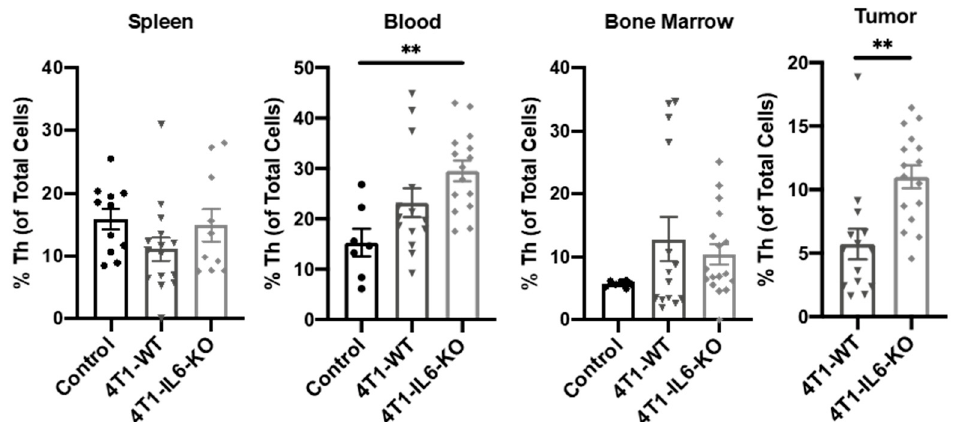
Figure 10. Knocking out tumor cell IL-6 production increases tumor-infiltrating CD3 + /CD4 + T helper cells. Tumors and peripheral tissues harvested 28 d after engraftment of 4T1-WT and 4T1-IL6-KO cell lines were analyzed for total CD3 + CD4 + T h cells. Healthy, non-tumor-bearing mice were analyzed for comparison (control); see Figure 2 for gating strategy. Data are presented as mean ± SEM; n = 4–11 mice/group. ** p < 0.01.